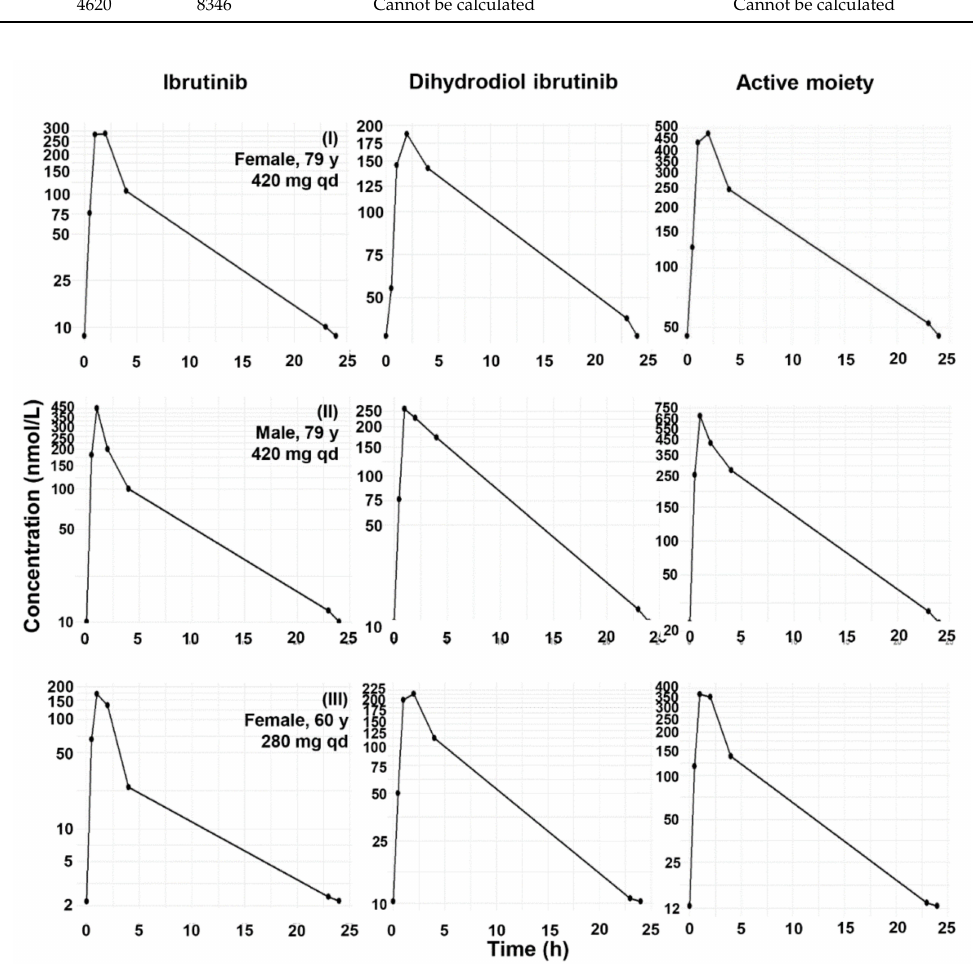
Figure 4. 24 h steady-state concentration profiles of IBR, DIB, and the active moiety (IBR + DIB) in three chronic lymphocyte leukemia patients taking 420 mg (Subjects I and II ) or 280 mg (Subject III ) IBR per